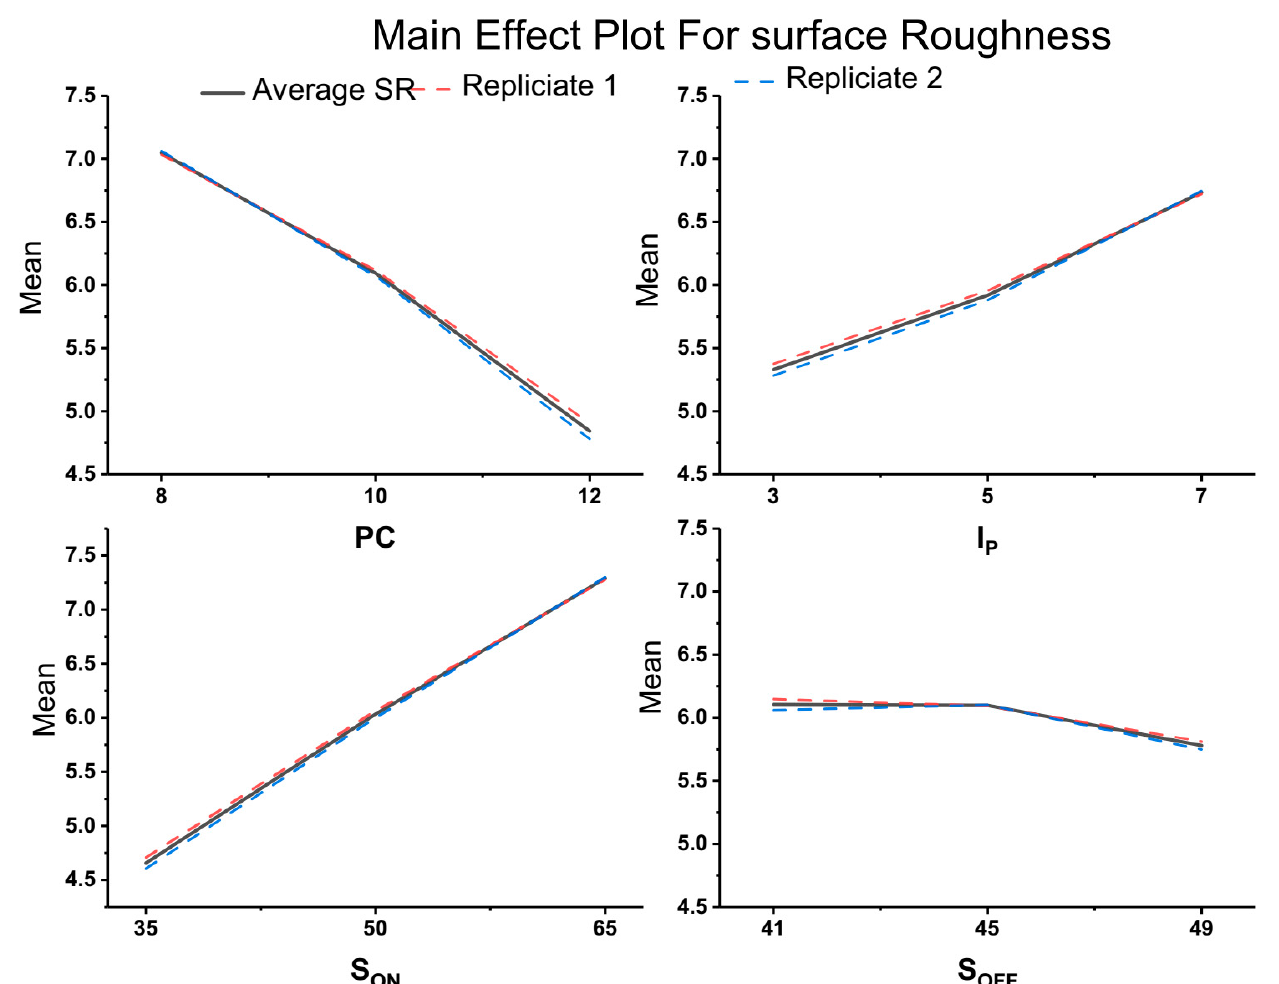
Figure 3. Main Effect Plots for Surface Roughness.